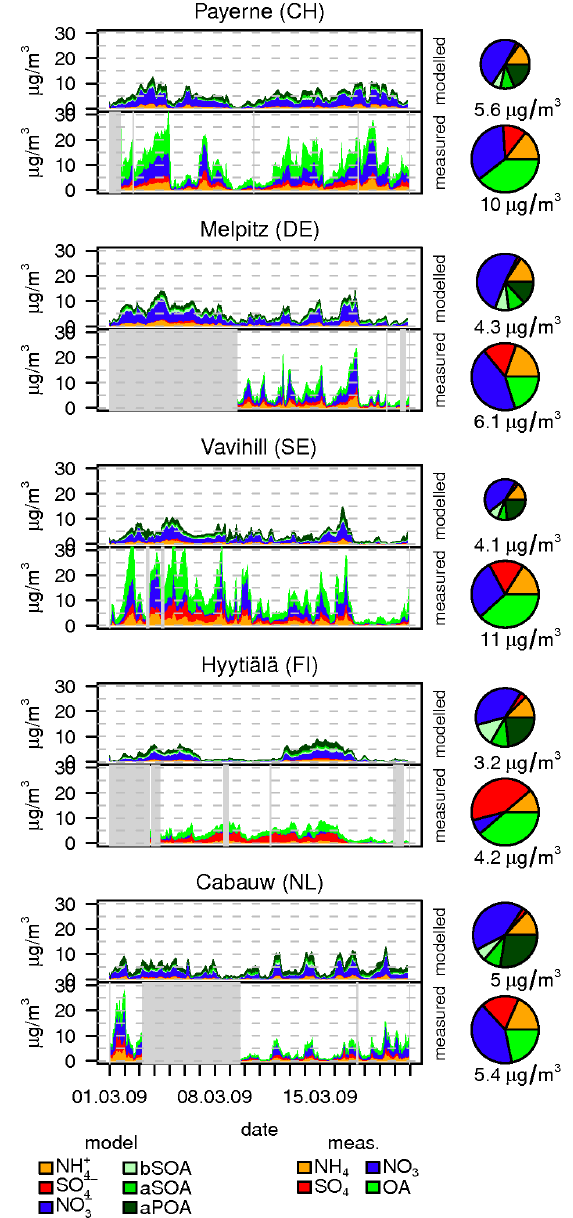
Fig. 10a. Timeline of aerosol chemical composition as in Fig. 9 but for stations measuring during the spring 2009 period (1 of 2).